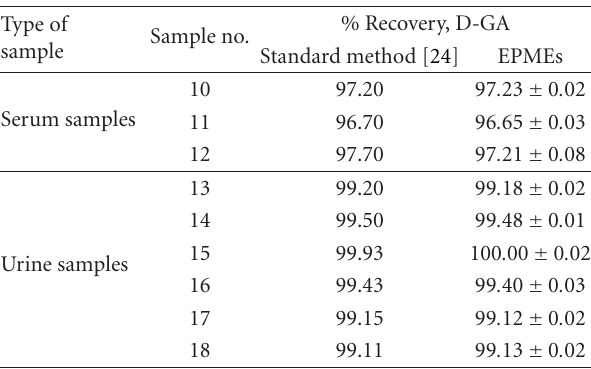
Table 6: Recovery of D-glyceric acid in serum and urine samples, (%) a . Sample